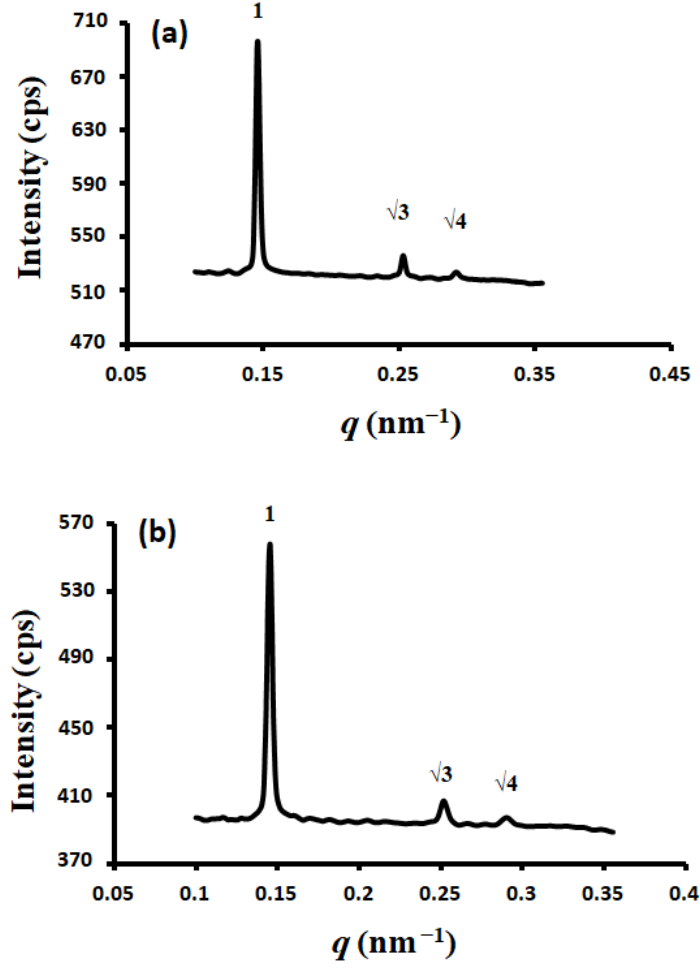
Figure 2. SAXS charts of PEG-GMO10 ( a ) and PEG-GMO20 ( b ) formulations.